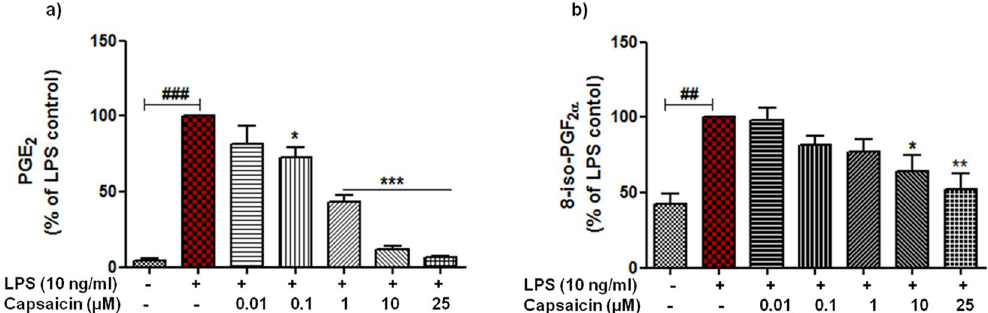
Figure 2. Capsaicin (cap) inhibits the release of prostaglandin E 2 (PGE 2 ) and 8-isoprostane (8-iso-PGF 2 α ) in lipopolysaccharide (LPS)-activated microglia. Microglia were pre-treated with cap (0.01–25 µ M) for 30 min, afterwards cells were incubated with or without LPS (10 ng/ml) for the next 24 h. At the end of incubation, cell supernatants were collected and release of PGE 2 ( a ) and 8-iso-PGF 2 α ( b ) were measured by enzyme